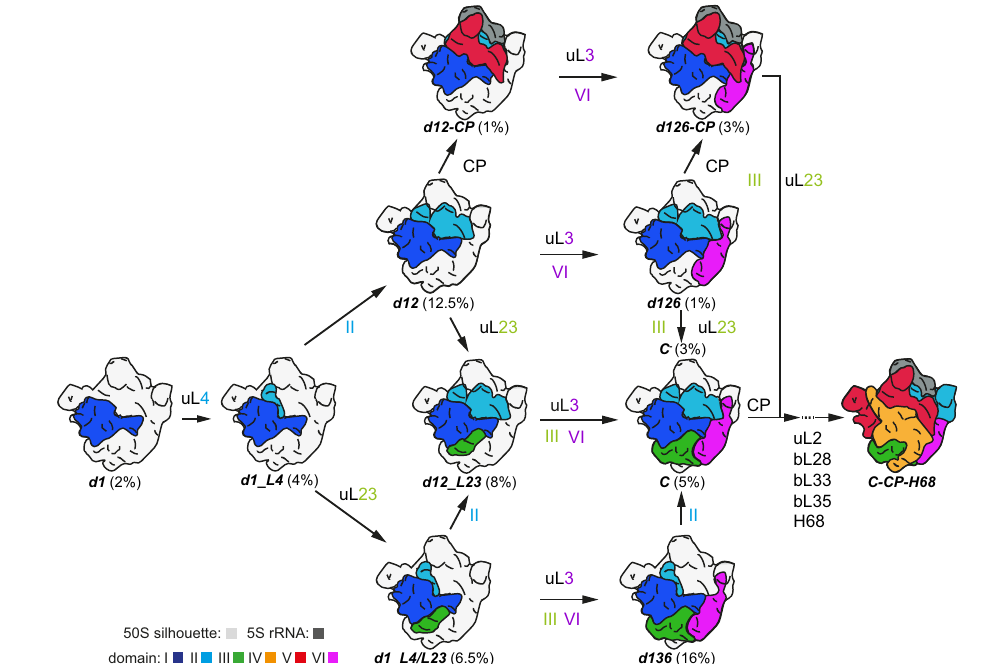
Fig. 6 | Model of early 50S assembly. Models of individual states color-coded as indicated. Numbers in % represent their relative abundance in the sorting scheme. Gray silhouette illustrates density of the mature 50Ssubunit. The labels uL4, uL23,